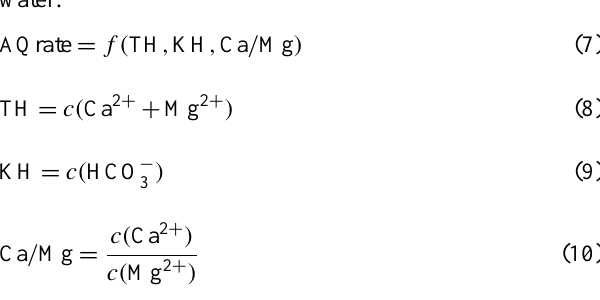
MTP. The maximum turning points correlate strongly with